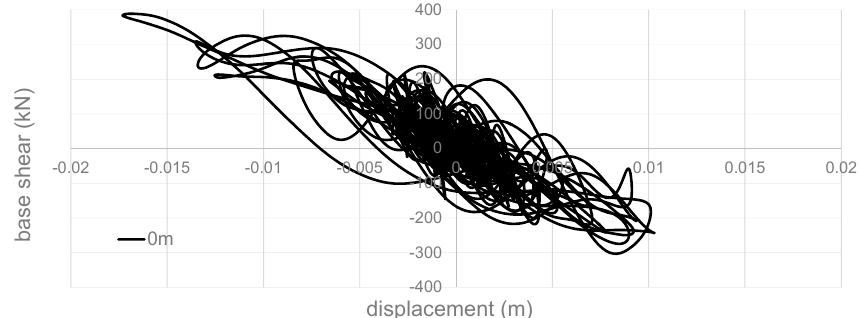
Figure 17. Model-0 m: base shear. Geosciences 2020 , 10 , x FOR PEER REVIEW